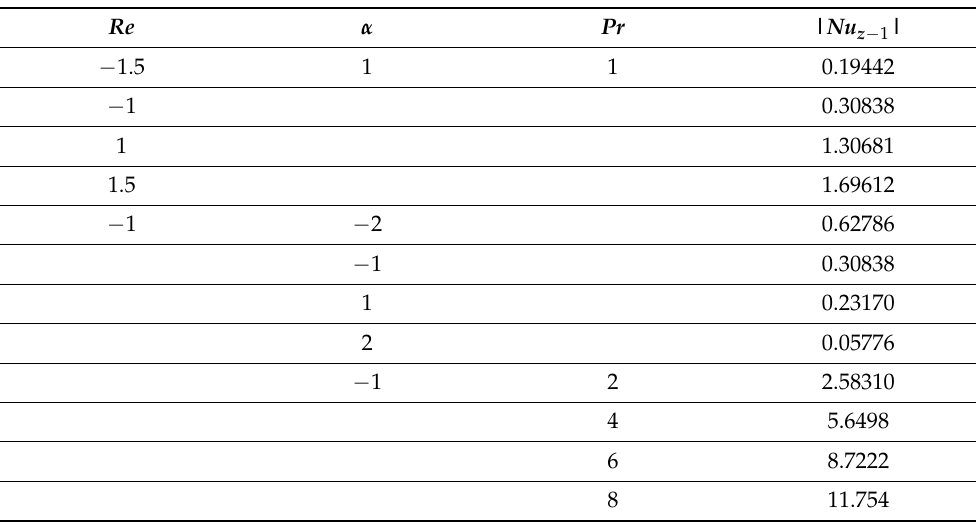
Table 6. Different nondimensional parameter effects on the Nusselt number.